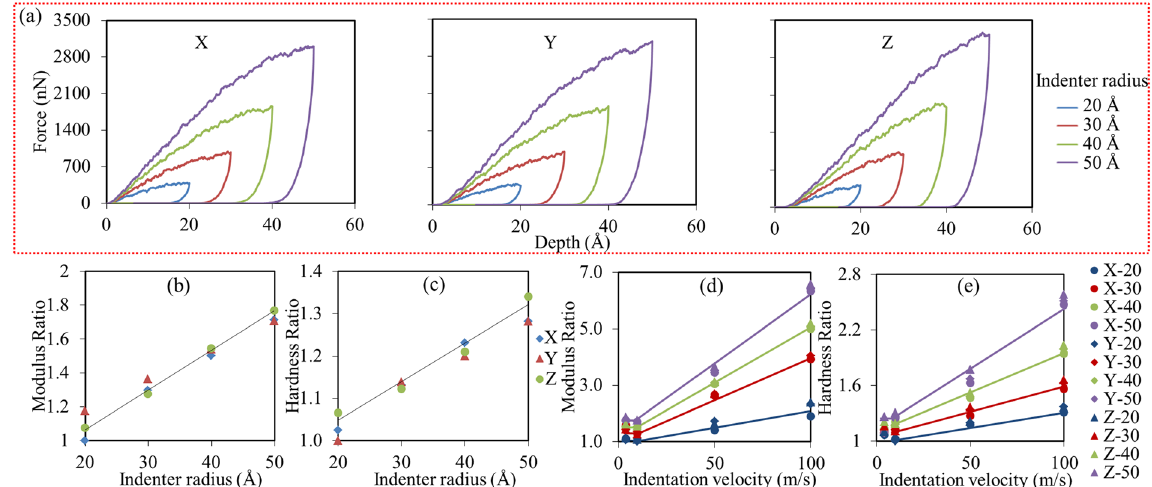
Figure 4. ( a ) Force-depth curves of nano-indentation. ( b ) Normalized indentation moduli versus indenter size ( c ) Normalized hardness versus indenter size; ( d ) Normalized indentation moduli versus loading rates ( e ) Normalized hardness versus loading rates. The normalization factor is the indentation modulus or hardness of the system with the smallest indenter